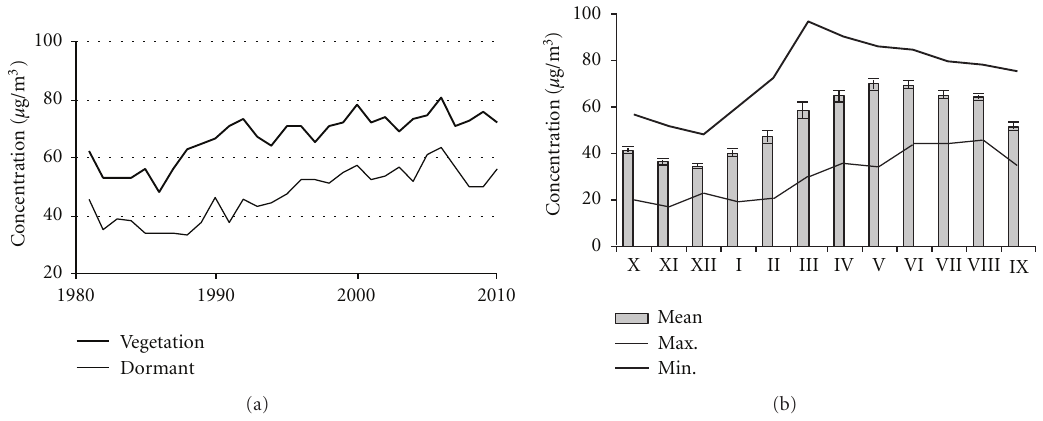
Figure 7: Variation in seasonal and monthly surface ozone concentrations at Preila EMEP station.